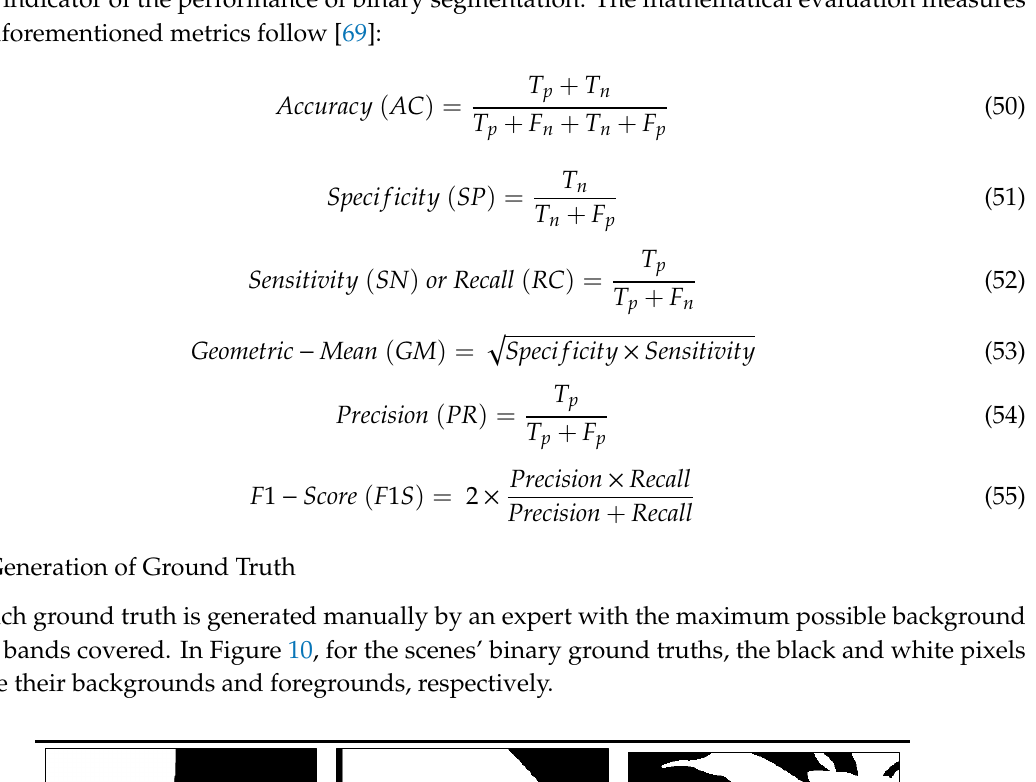
Table 2. Evaluation of direct- vs. fusion-based BS performances for three scenes in the MSPI dataset.